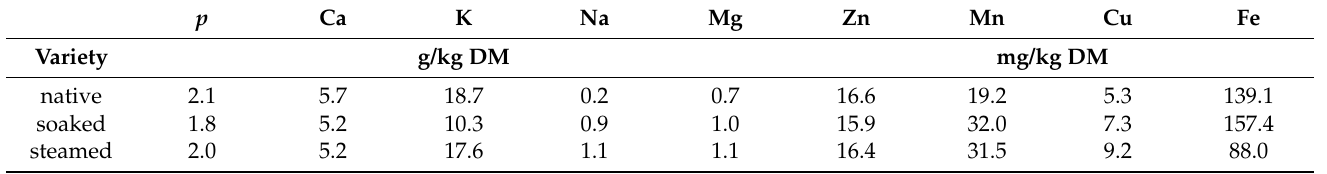
Table 4. Measured contents of macro and trace elements in the native and treated